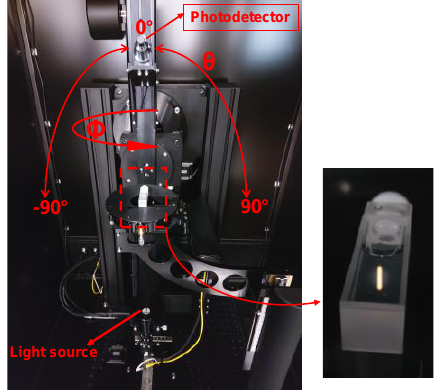
Fig. 1. Multi-angle static light scattering measurement